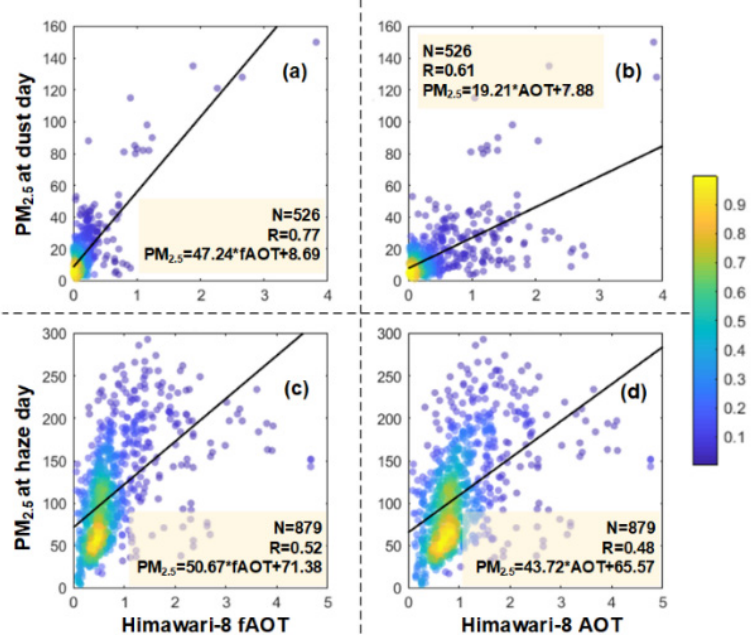
Figure 10. ( a ) linear correlation between Himawari-8 fAOT and PM 2.5 on dust day (3 June 2020); ( b ) linear correlation between Himawari-8 AOT and PM 2.5 on dust day (3 June 2020); ( c ) linear correlation between Himawari-8 fAOT and PM 2.5 on haze day (12 February 2020); ( d ) linear correlation between Himawari-8 AOT and PM 2.5 on haze day (12 February 2020).